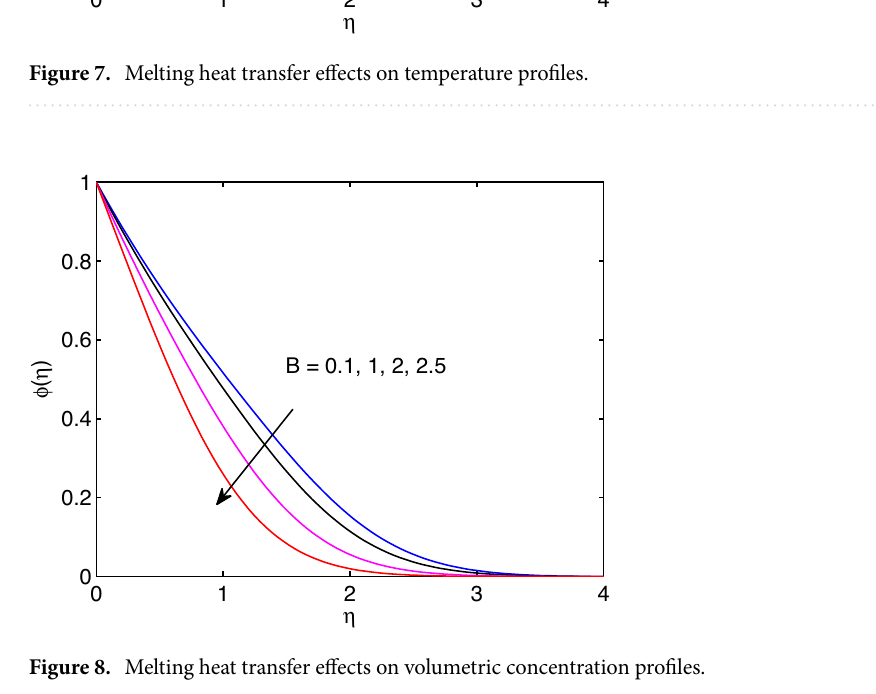
Figure 8. Melting heat transfer effects on volumetric concentration profiles.